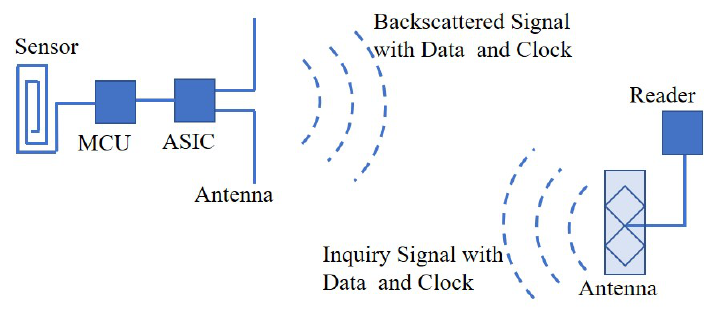
Figure 1. Fundamental of an ultra-high frequency (UHF-RFID) sensor